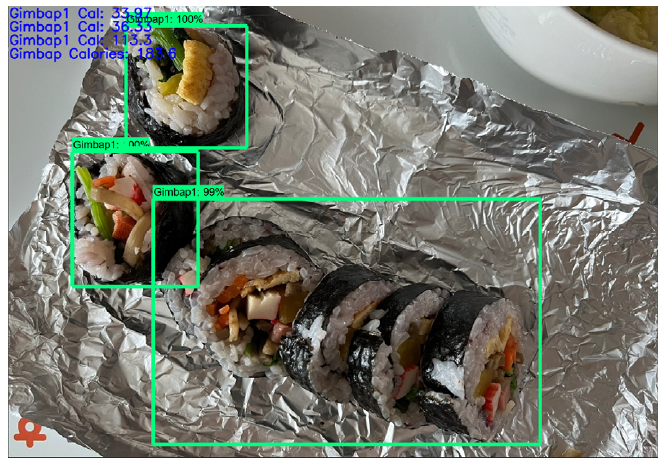
Figure 11. Calorie estimation result based on Faster R-CNN algorithm. Because it does not consider the unseen Gimbap, the calorie estimation result is much less than normal.